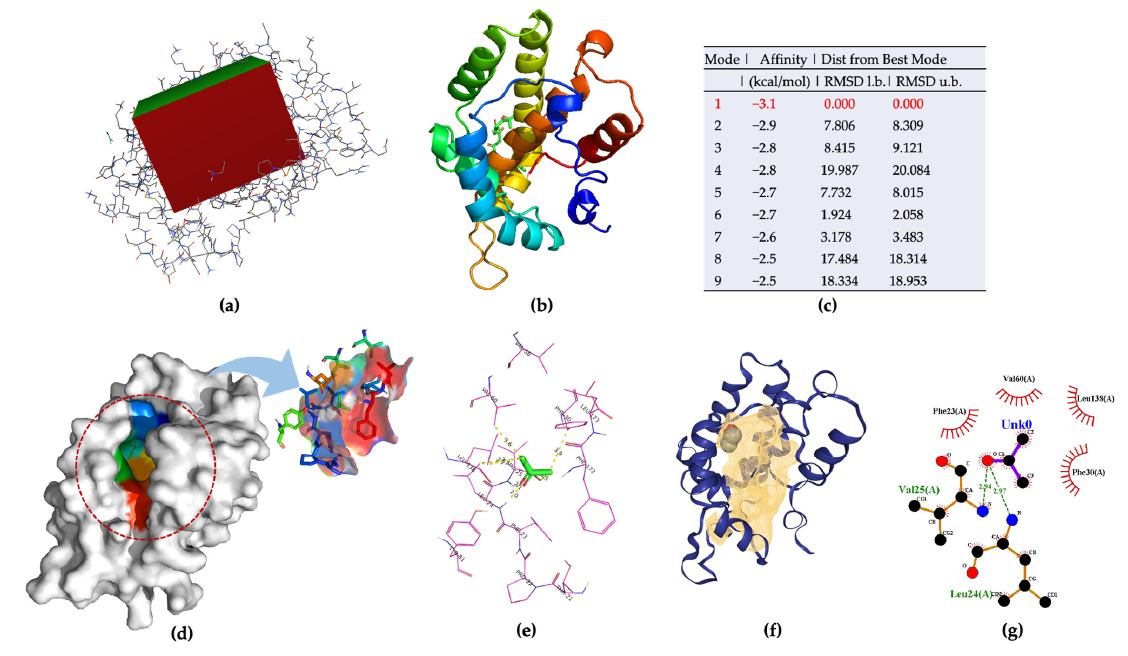
Figure 5. ( a ) Grid box for AgamOBP47–acetone docking model; ( b ) nine docking models predicated using AutoDock Vina; ( c ) ranking results of docking model; ( d ) 3D visualization of the best docking model; ( e ) Binding residues identification; ( f ) best position of predicted binding pocket; ( g ) 2D ligand–protein interaction diagrams of AgamOBP47 (PDB ID:3PM2) with acetone.